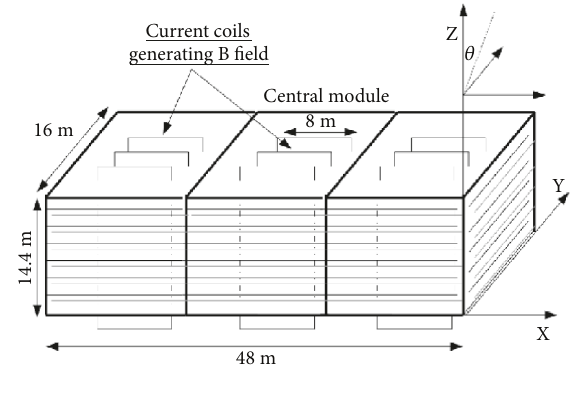
Figure 1: Schematic view of the INO-ICAL detector geometry.